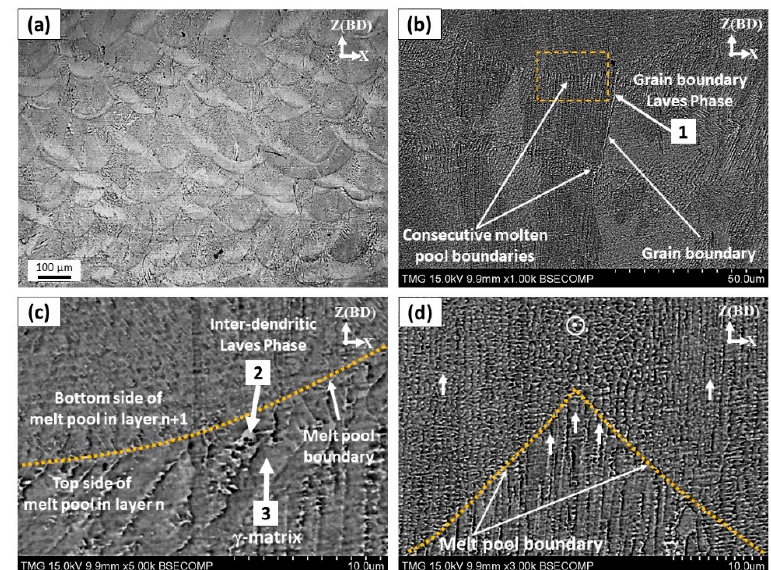
8 of 25 Figure 4. SEM micrograph of the non ‐ etched as ‐ printed laser powder bed fused IN718 superalloy: ( a ) vertical plane (xz); ( b ) horizontal plane (xy). To characterize the dendritic microstructure and obtain further details about the as ‐ printed substructure, both the xz and xy ‐ planes were etched and examined as shown in Figures 5 and 6, respectively. After etching, the melt pool boundaries can be clearly seen in the OM micrograph of the xz ‐ plane in Figure 5a. The shape of the molten pool appears as arc ‐ shaped contours facing upwards along the building direction, which reflects the Gaussian distribution shape of the laser beam intensity. This is the typical microstructure of the laser powder bed fused IN718 superalloy as also reported in [7,24,25]. The microstructure of each individual melt pool consists of very fine columnar dendrites as shown in Figure 5b–d. The growth direction and size of the dendrites in the molten pool depend on the direction of the local thermal flux and the cooling rate, respectively [26]. Moreover, the <100> texture is the preferred crystallographic orientation for the FCC structure [2]. This strong texture was observed to be preferential for many FCC engineering materials, built using the laser and electron beam powder bed fusion (PBF) processes [27,28]. Therefore, anisotropic mechanical properties are expected for the as ‐ printed IN718 superalloy. Also, as shown in Figure 5b, some of these columnar dendrites extend across several melt pools, suggesting that the epitaxial growth of new dendrites occurred upon the preexisting dendrite colonies of the solidified grains along the building direction. This is because, during the laser beam scanning, the laser radiation causes extremely fast melting of the current powder layer and also partial melting of the previously solidified layer. After the laser beam leaves the melt pool, rapid cooling of the molten pool and rapid